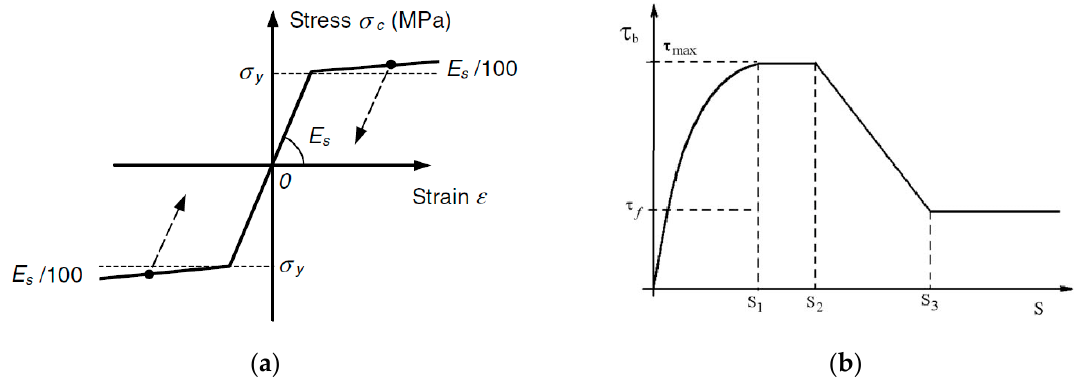
Figure A2. Model for the reinforcement: ( a ) stress–strain curve for the steel reinforcement; ( b ) bond–slip law based on CEB-Figure 1990.